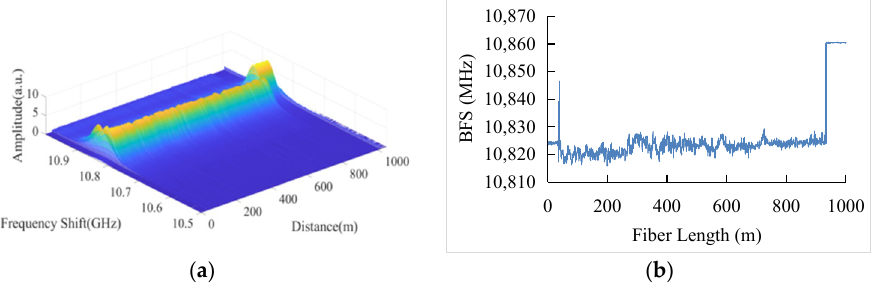
Figure 8. ( a ) Measured BGS distribution along 1000 km FUT with last 1000 m section heated at 30 °C, and ( b ) BFS distribution.